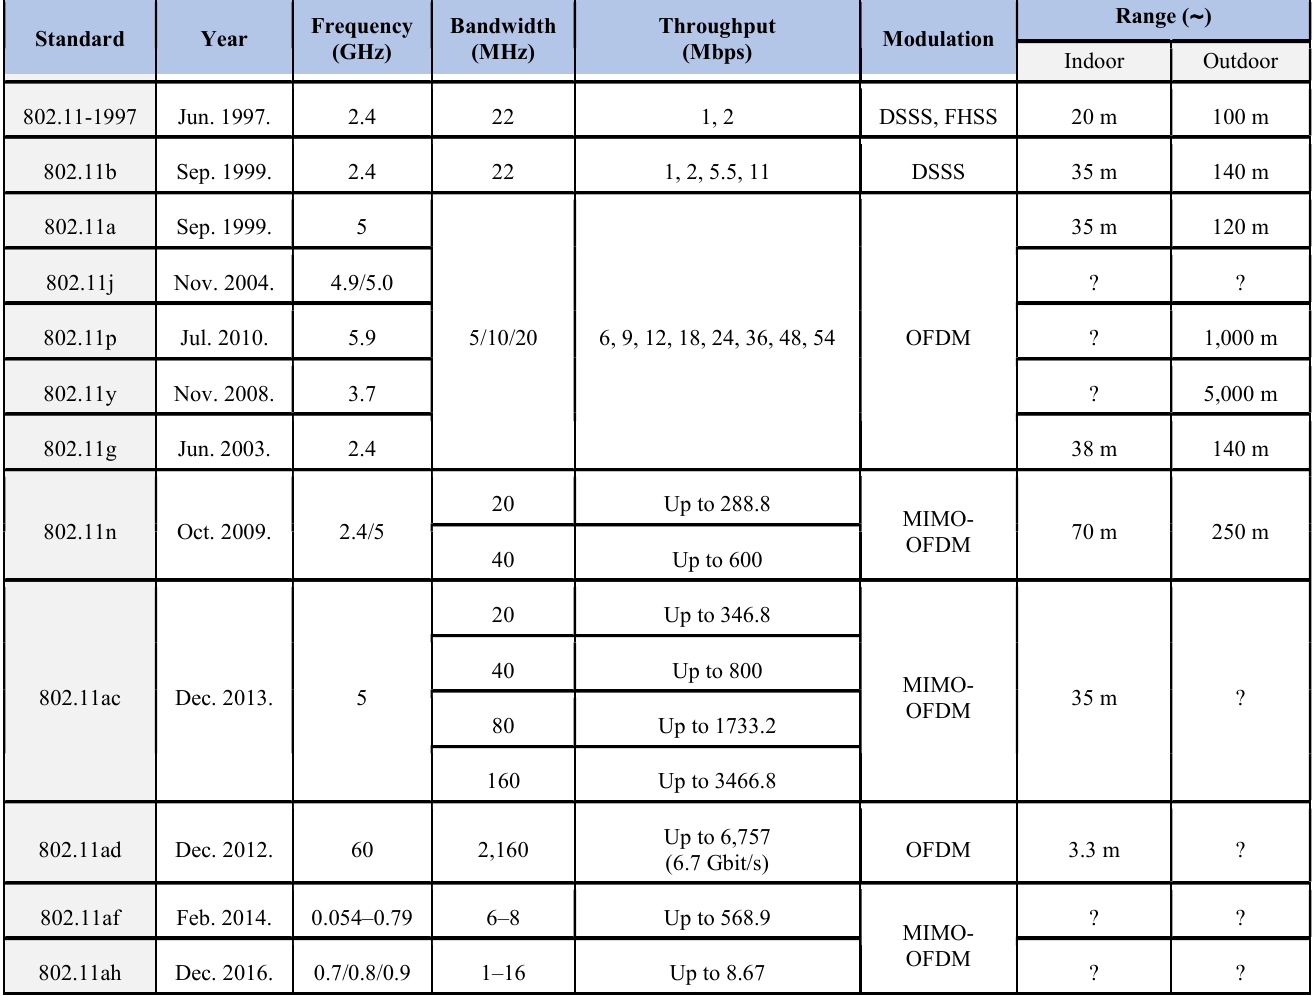
Table 3. An overview of Wi-Fi